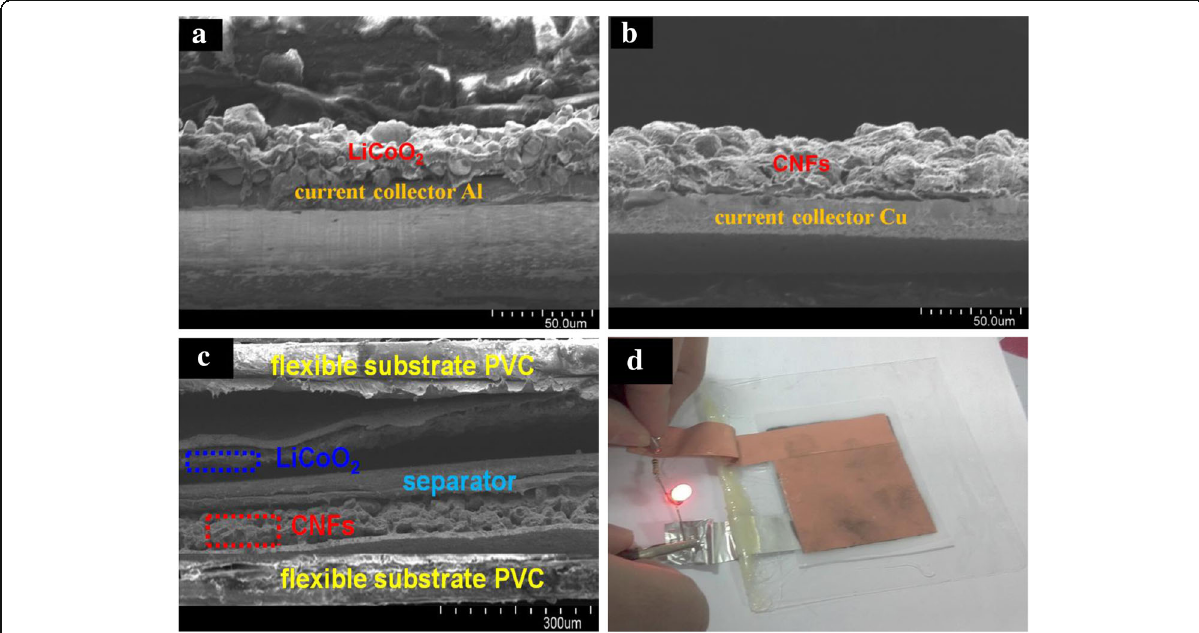
Fig. 2 The cross-sectional images of a LiCoO 2 /Al film (cathode), b CNFs/Cu film (anode) and c flexible full cell, d photograph of LED lightened by the assembled full